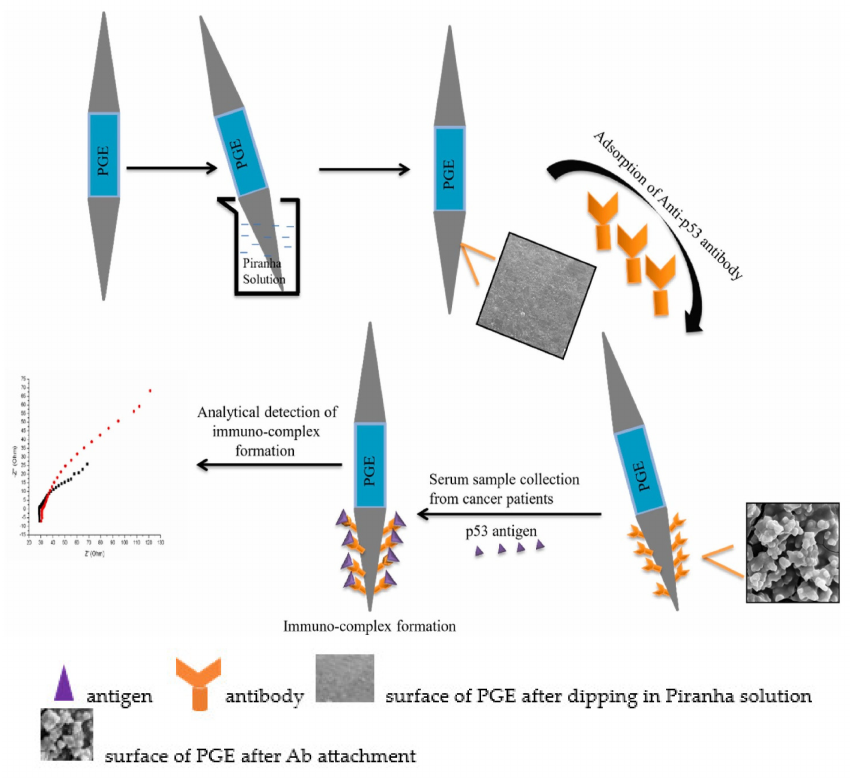
Figure 8. Steps in the fabrication of EC immunosensor. PGE: Pencil graphite electrode; Ab: antibody. Reprinted with permission from [75], published by Elsevier,